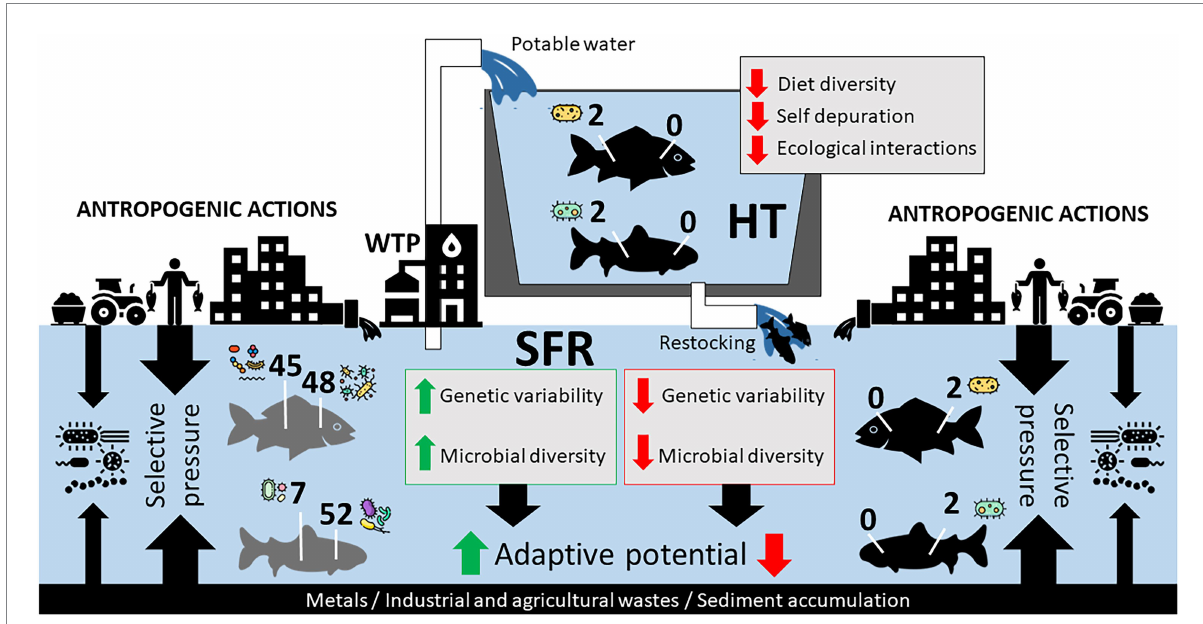
FIGURE 5 Hypothetical model of the adaptive relationship of species in SFR, in HT, and after being returned to SFR after restocking. Impacts of anthropogenic actions in SFR and zootechnical management in HT on the constitution of R. aspera and P. argenteus microbiomes should contribute to microbiota structure. The reduction of genetic diversity and the gill and gut microbiota can massively interfere with the adaptation of fish after